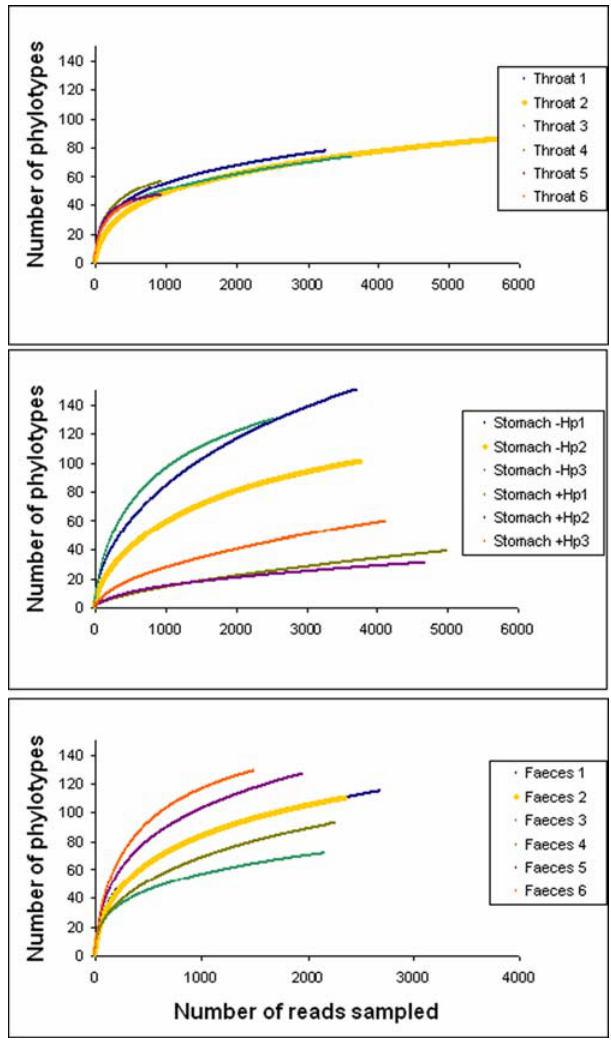
Figure 4. Rarefaction analysis of the different gut ecosystems. Number of phylotypes sampled as a function of number of reads. The data points represent averages of 1000 randomized samplings without